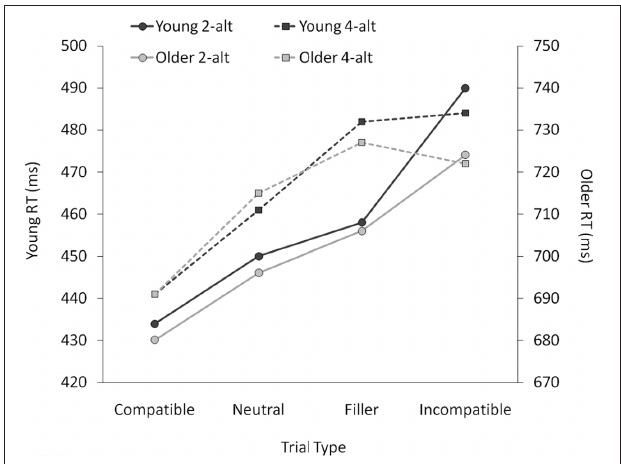
FIGURE 2 | Mean correct response times (RTs) in ms for young and older adults as a function of trial type, plotted separately for the 2-alternative (2-alt) and 4-alternative (4-alt) choice tasks. Note that the two y-axes (left: young adults’ mean RTs; right: older adults’ mean RTs) use the same scale, but have a 250-ms onset